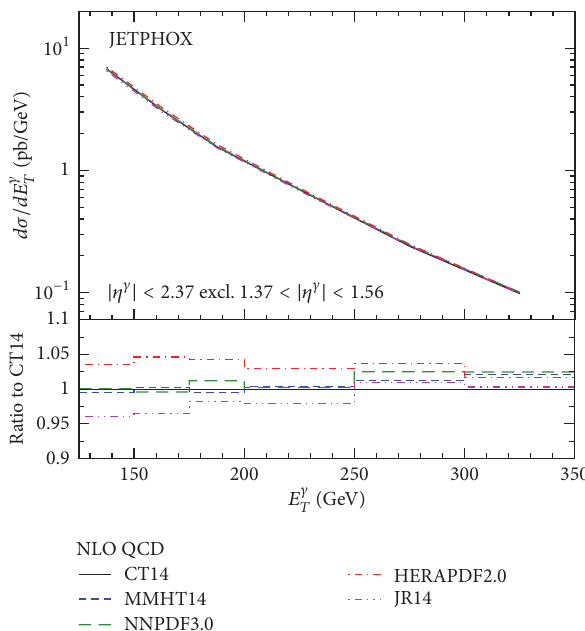
Figure 3: A comparison of the NLO theoretical predictions for the total differential cross section of the isolated prompt photon 𝛾 productionasafunctionof 𝐸 𝑇 usingvariousNLOPDFsofCT14[92] (black solid curve), MMHT14 [93] (blue dashed curve), NNPDF3.0 [94] (green long-dashed curve), HERAPDF2.0 [95] (red dotted- dashed curve), and JR14 [96] (pink dotted-dotted-dashed curve) at √𝑠 = 13 TeV in the kinematic range 125 < 𝐸 𝛾 < 350 GeV for 𝑇 |𝜂 𝛾 | < 2.37 excluding the region 1.37 < |𝜂 𝛾 | < 1.56 . Ratio to the central value of CT14 has been shown in the bottom